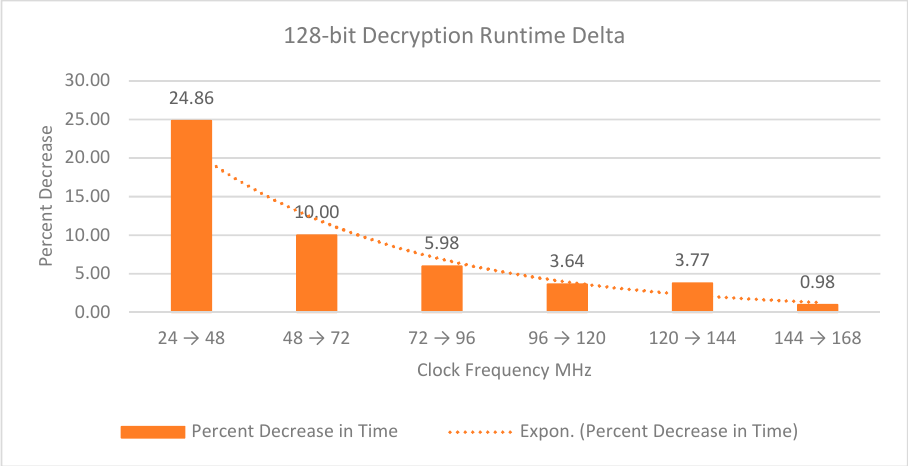
Figure A3. Energy consumed to complete decryption with various clock frequency.